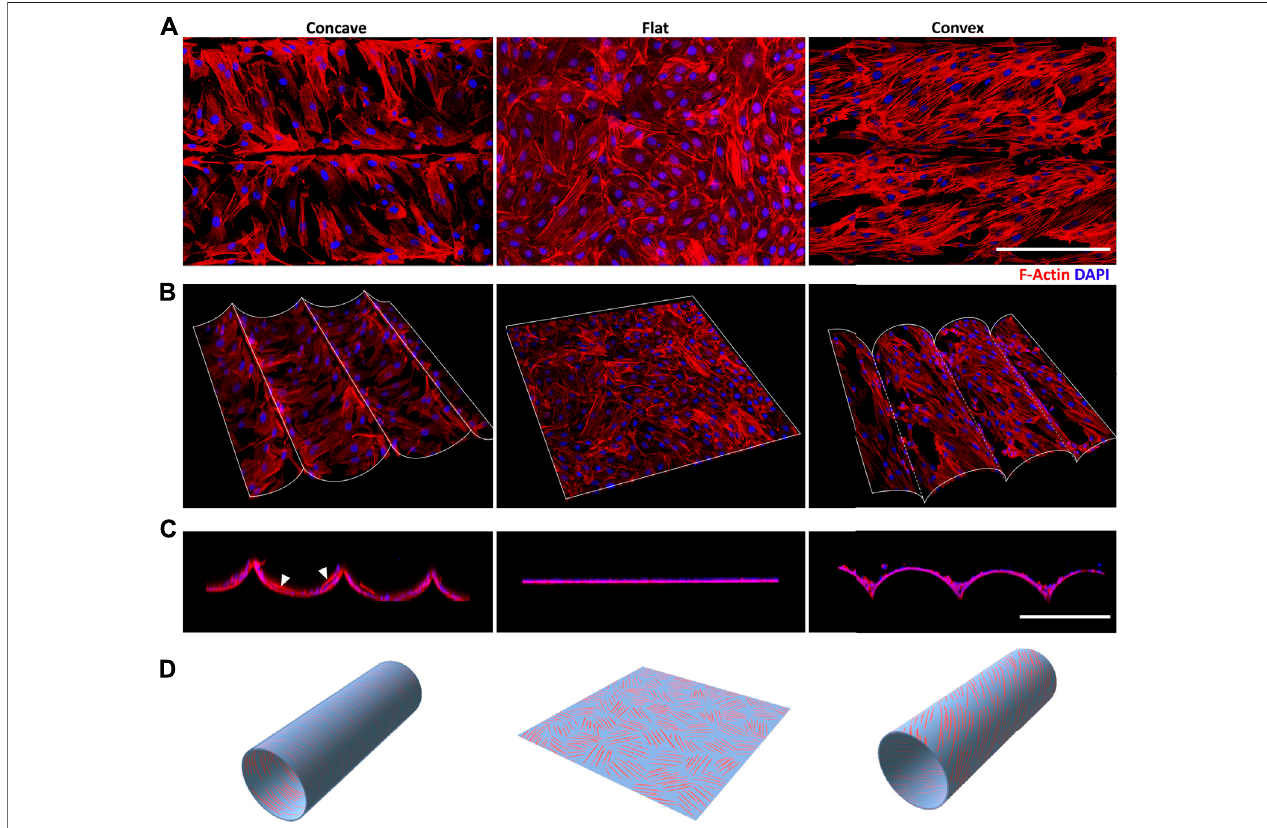
FIGURE2| Curvature-inducedstress fi bers(SFs)helicalarrangementofASMCs (A) Thedistribution ofRhodaminelabeled SFs(red)and DAPIlabeled nuclei(blue) obtained via the projection of section-scanned image sequences from laser scanning confocal microscopy ( R (cid:1) 100 μ m) (B) Free view and (C) side view of 3D reconstructed ASMCs layer on the curved surfaces (D) The schematic illustration shows three different patterns of SFs helical distribution induced by concave, fl at and convex surfaces. Scale bar (cid:1) 200 μ m.